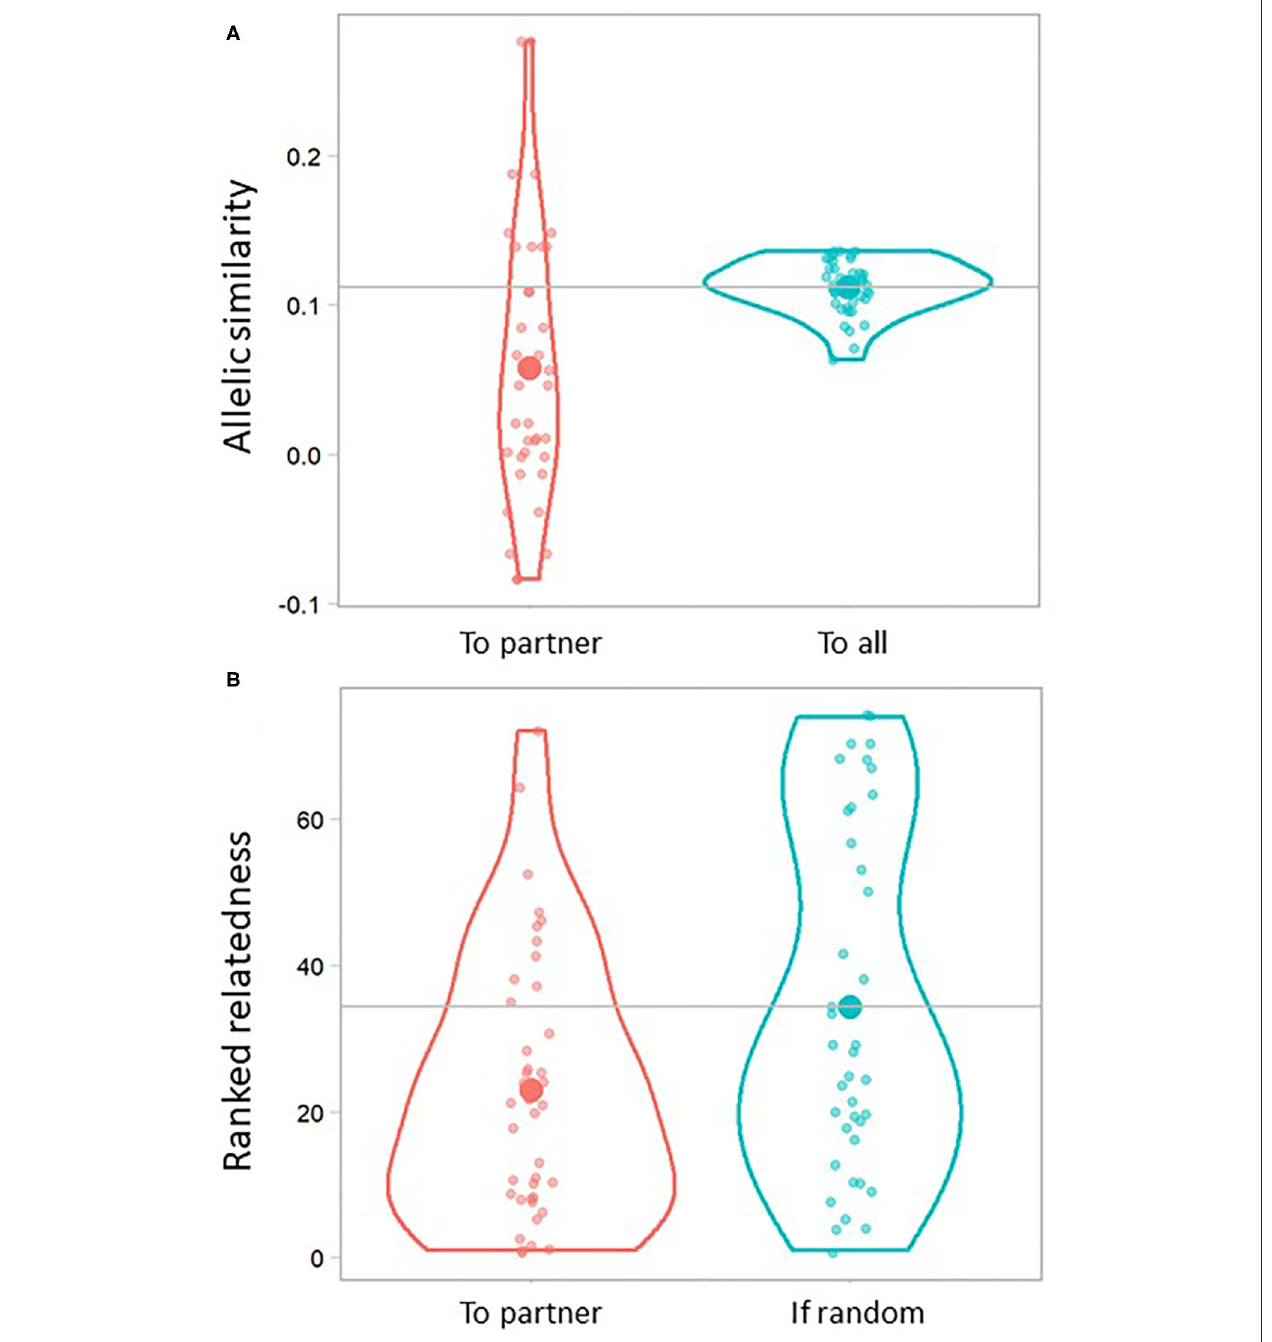
FIGURE 4 | Violin plots illustrating relatedness of paired individuals to their partner ( n = 40 datapoints representing 20 pairs). (A) Pairwise relatedness based on allelic similarity between each paired bird and its partner (left) and the average pairwise relatedness based on allelic similarity of each paired bird to all other birds in the entire sample set (right; n = 74). (B) Ranked (or relative) relatedness of each paired bird to its partner (left) compared to one example iteration of 40 randomly generated rank values. A ranking of 1 indicates that the partner of a paired bird was the least related individual in the sample set, while a ranking of 73 indicates that the partner was the most related bird in the data set. Small dots represent each data point, and the shape of the violin outline represents their distribution. Large dots represent the average. Horizontal grey lines indicate average allelic similarity and ranked relatedness, respectively, expected under the null hypothesis of random mating.